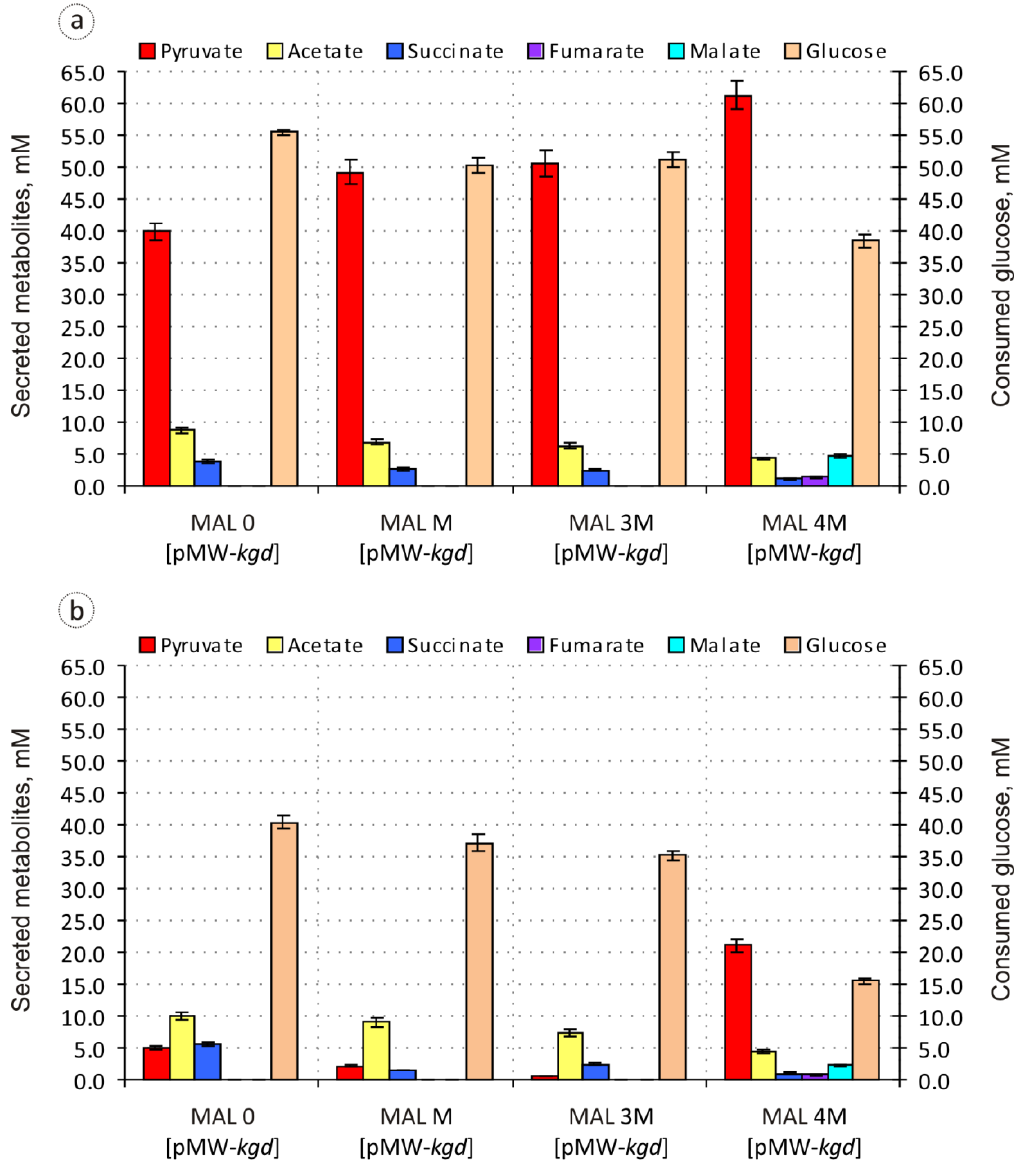
Figure 2. Metabolite production and substrate consumption by the strains MAL 0 [pMW- kgd ], MAL M [pMW- kgd ], MAL 3M [pMW- kgd ], and MAL 4M [pMW- kgd ] during 8 h of aerobic glucose utilisation in the absence ( a ) or presence ( b ) of IPTG.